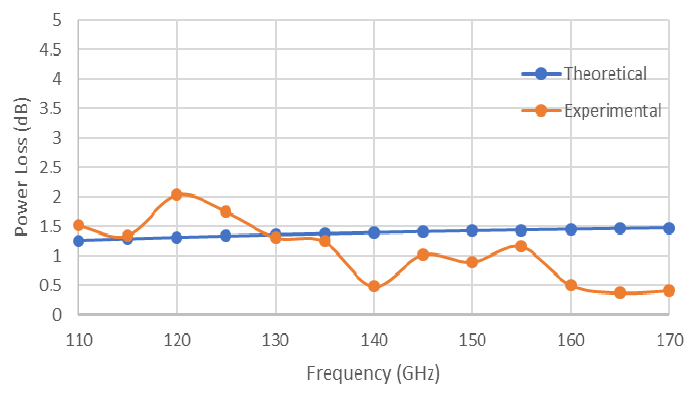
Figure 6: Comparison of theoretical and experimental values for coupling loss